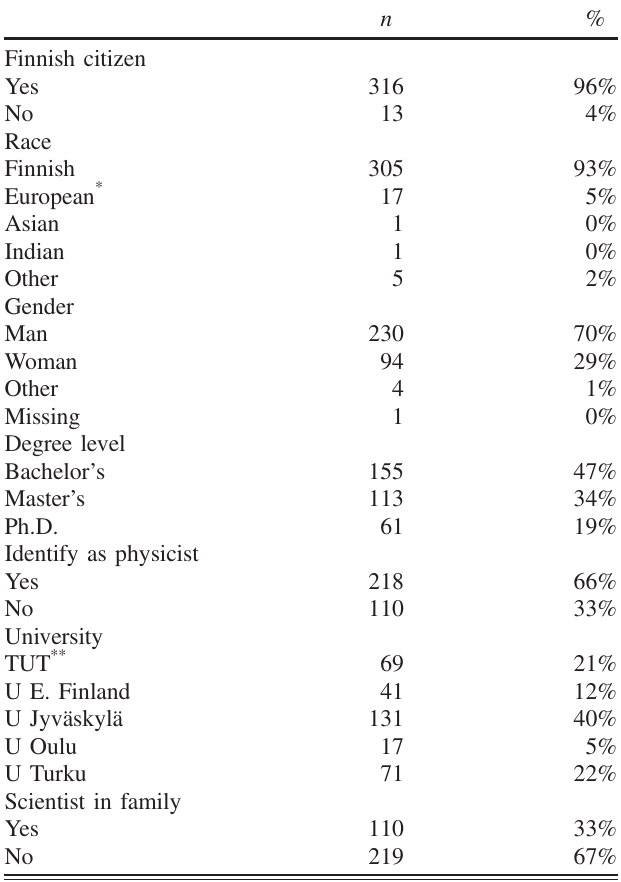
TABLE I. Participant